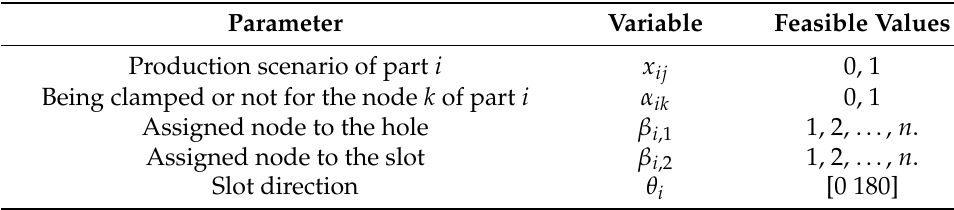
Table 2. Design parameters. Parameter Variable Feasible Values Production scenario of part